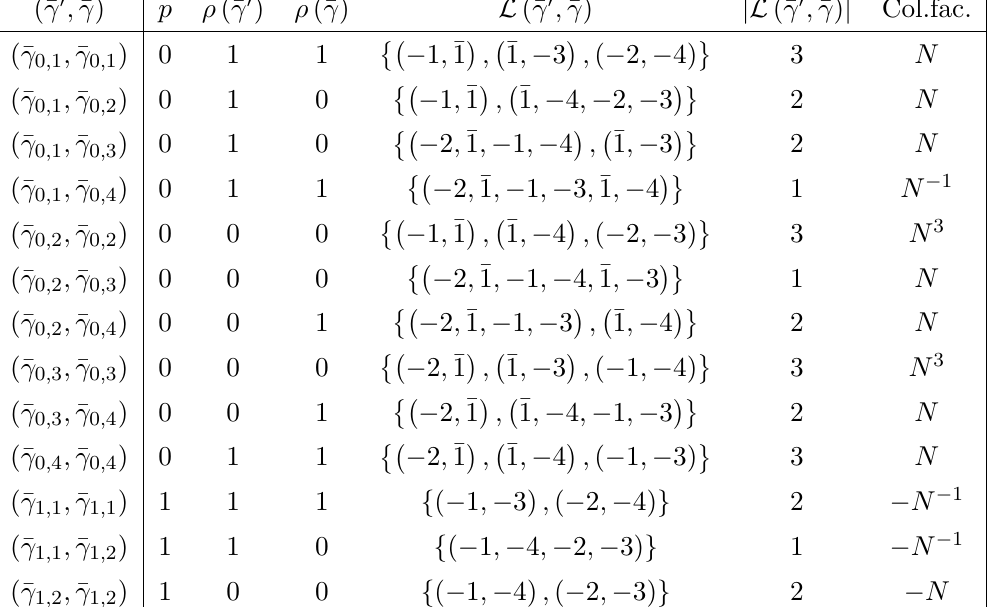
Table 2 . As in table 1, for ¯ qq → q 0 ¯ q 0 g